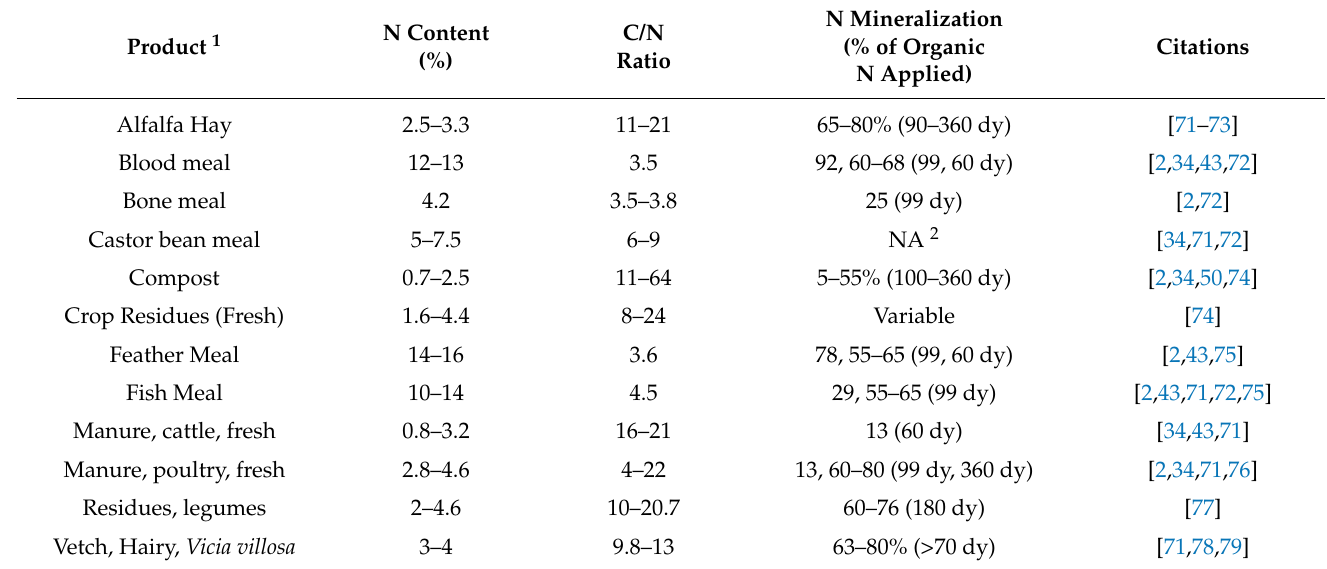
Table 1. Nitrogen content of several organic amendments used by organic and subsistence